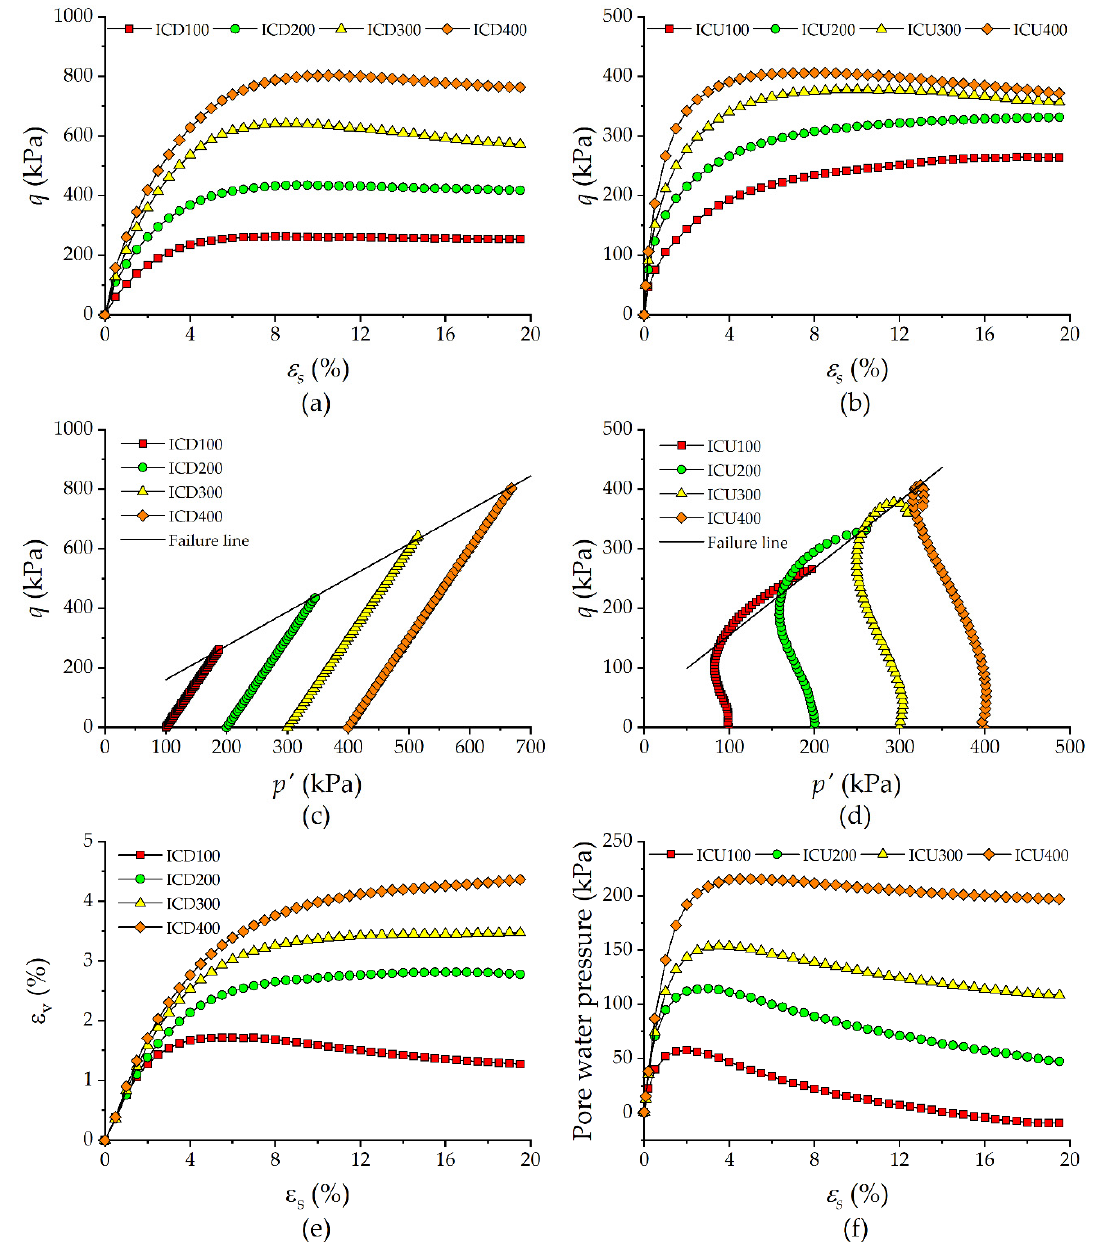
Figure 5. Results of ICD and ICU tests: ( a ) q − ε s curves of ICD tests; ( b ) q − ε s curves of ICU tests; ( c ) effective stress paths of ICD tests; ( d ) effective stress paths of ICU tests; ( e ) ε v −ε s curves of ICD tests; ( f ) ε v −ε s curves of ICU tests.